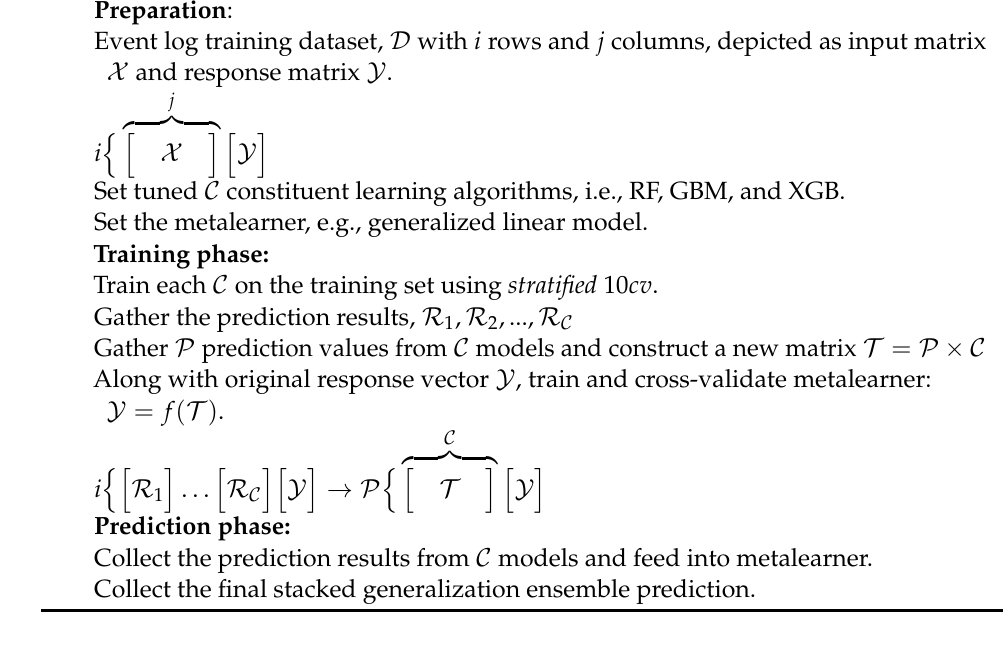
Algorithm 1 Procedure to construct a stacked generalization ensemble with an internal 10 cv for outcome-based predictive monitoring of business